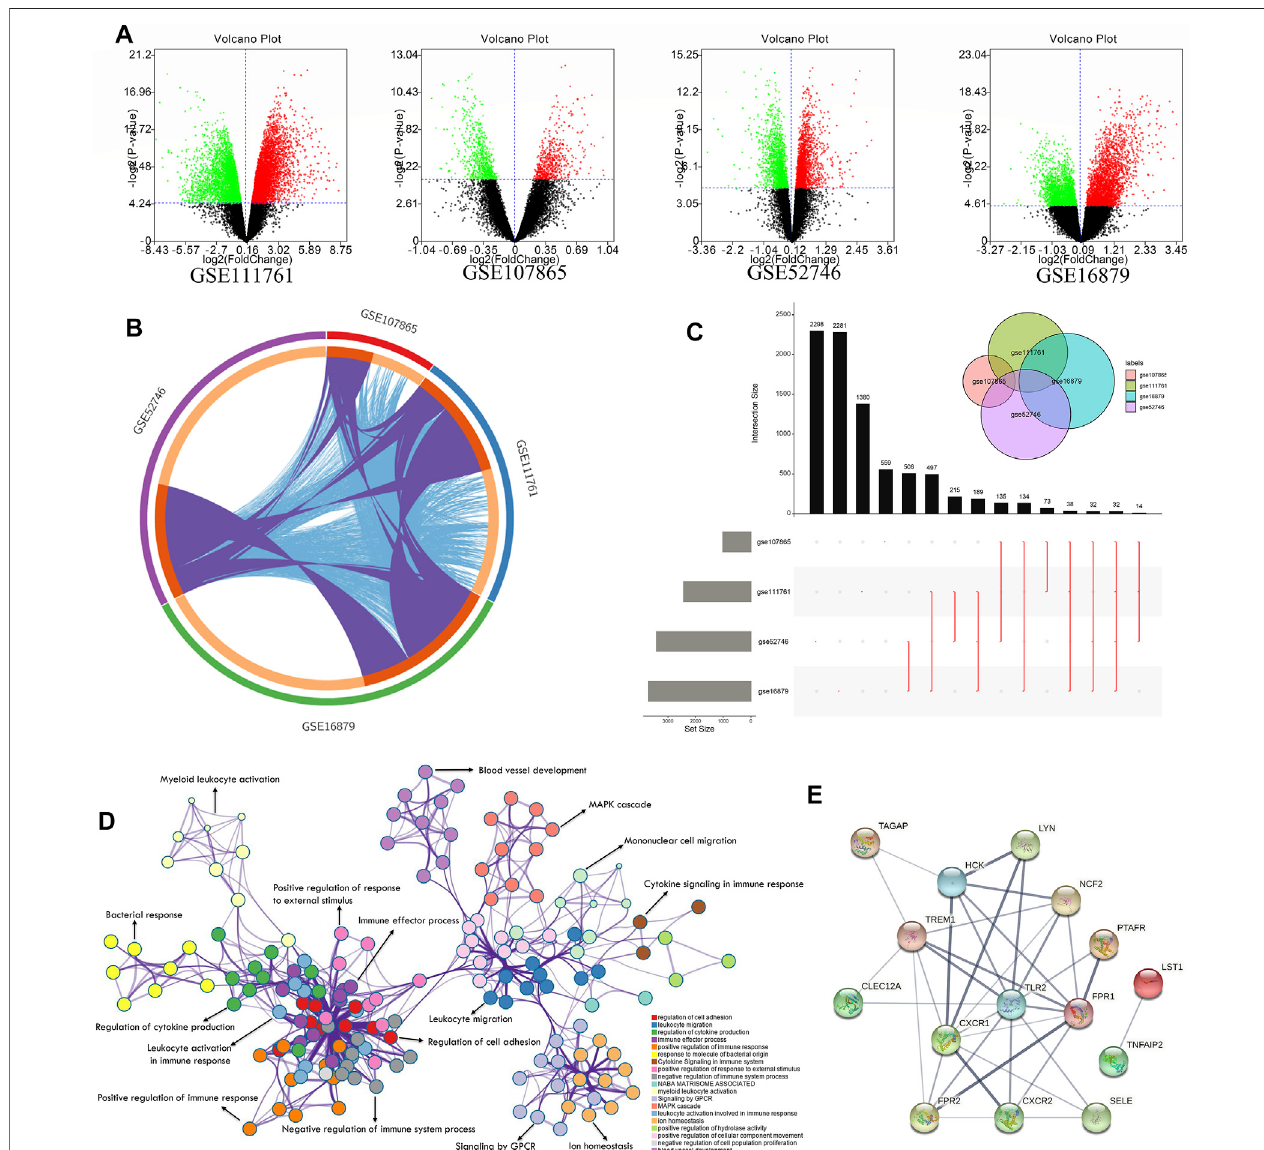
FIGURE 2 | Exploration of differentially expressed gene network between anti-TNF responders and nonresponders with CD. (A) Volcano plot of the discovery cohortsGSE111761,GSE107865, GSE52746,andGSE16879showingsigni fi cantlyupregulatedgenes(reddots)anddownregulatedgenes(greendots) with p < 0.05 betweenrespondersandnonresponders. (B) Circlediagramindicatingshareddifferentiallyexpressedgenes(purple)andinteractingdifferentiallyexpressedgenes(blue) among the four discovery cohorts. (C) Plot showing shared differentially expressed genes among the four discovery cohorts. Black columns show the number of shared genes, and the gray columns show the total number of signi fi cant differentially expressed genes in each cohort. Red lines show details of the shared genes (see also SupplementaryTableS1 ). (D) Networkresults inGOenrichmentanalysis. (E) Corenetworkofcommon differentially expressedgenesobtainedfromtheSTRING